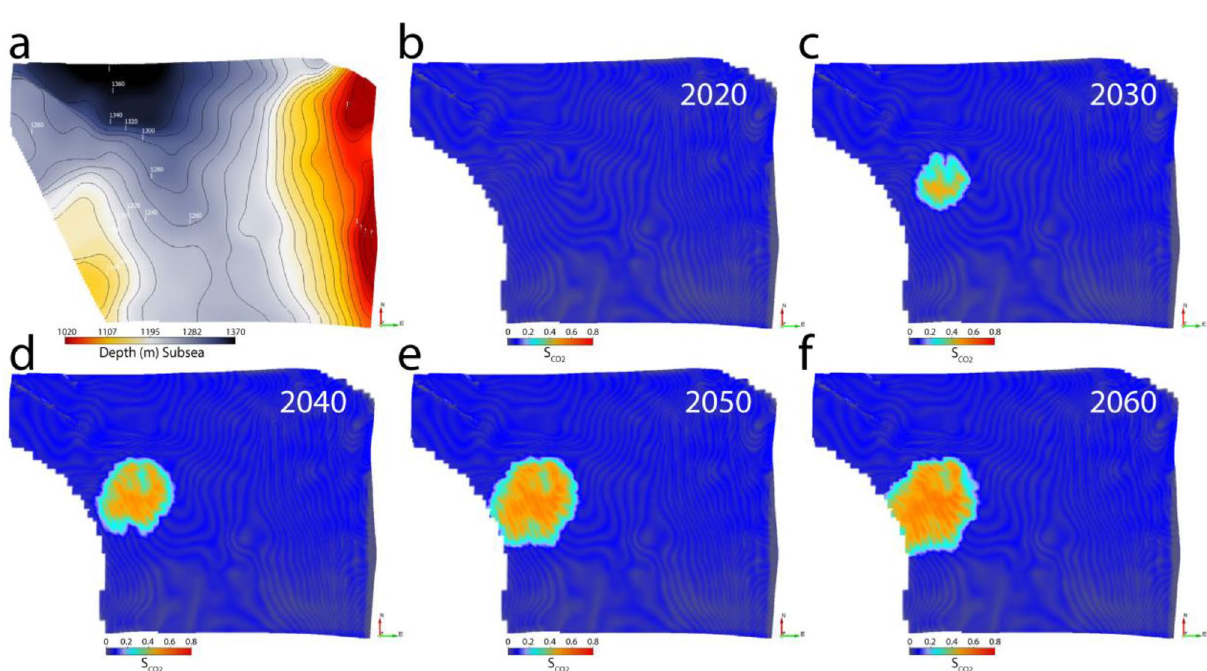
Figure 4. The top reservoir depth surface ( a ) draped on Case 1 CO 2 saturation cubes in year ( b ) 2020, ( c ) 2030, ( d ) 2040, ( e ) 2050, and ( f ) 2060. The CO 2 plume moves up-dip over time towards the